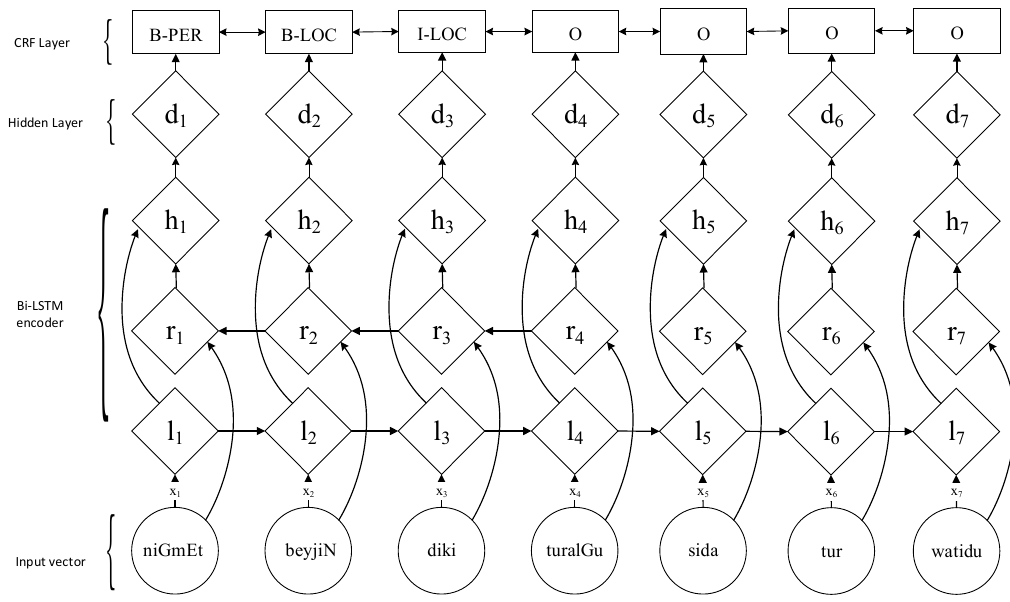
Figure 2. Bi-LSTM–CRF model based subword sequence with single-point segmentation.